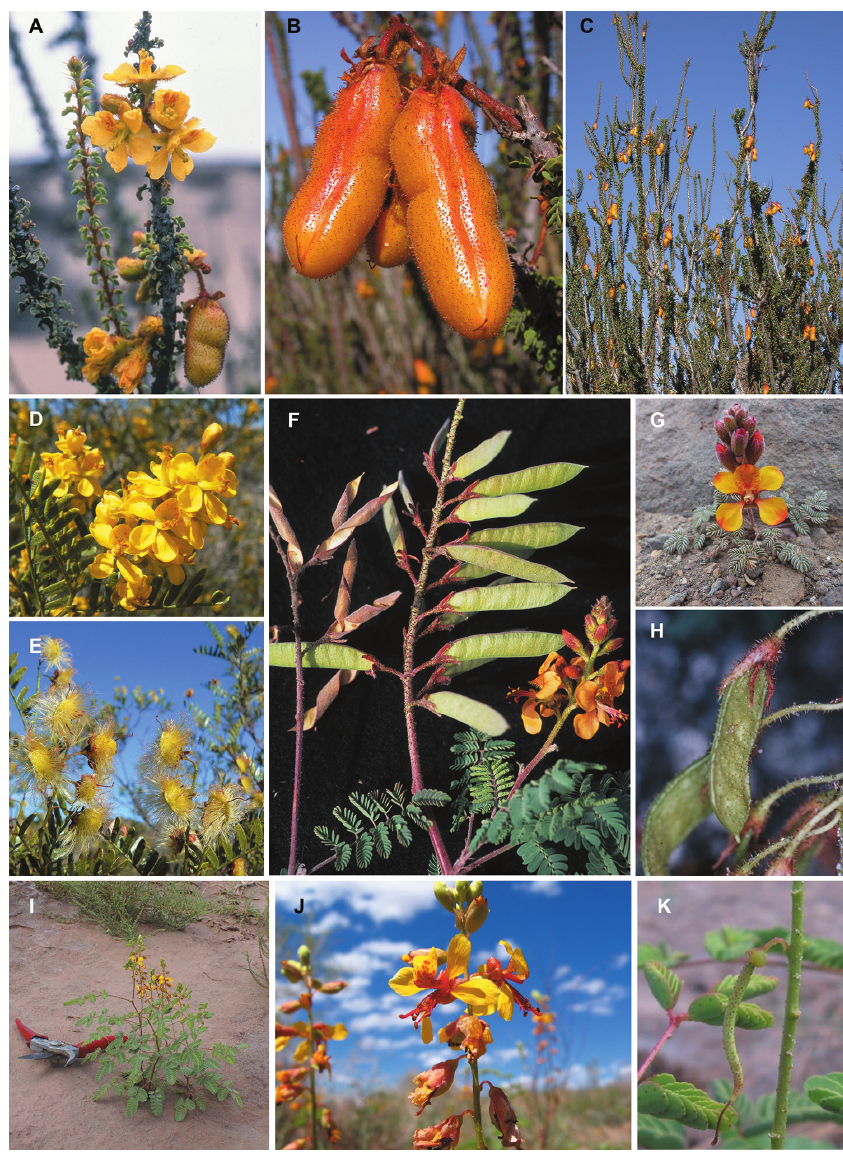
Figure 34. Balsamocarpon brevifolium Clos. A branch with inflorescence and fruit (M.F. Gardner, Chile, Gardner & Knees 5825 (E)) B fruits with persistent calyx, C habit (P. Baxter, Chile, Baxter et al. DCI 1859 (E)). Zuccagnia punctata Cav. D flowers E fruits (I. Specogna, Flora mendocina (http://www.flora- mendocina.com.ar/), Mendoza, Argentina, unvouchered ). Hoffmannseggia arequipensis Ulibarri F fruits with persistent calyx, and inflorescence (C. E. Hughes, Arequipa, Peru, Hughes et al. 2342 (FHO)). Hoffmannseggia minor (Phil.) Ulibarri, G habit and inflorescence (G. P. Lewis, Bolivia, unvouchered ). Hoffmannseggia humilis (Mart. & Galeotti) Hemsl. H fruit with persistent sepals (J. Neff, Puebla, Mexico, unvouchered ). Stenodrepanum bergii Harms I habit J inflorescence K fruit (R. H. Fortunato, Argentina, Fortunato 9144